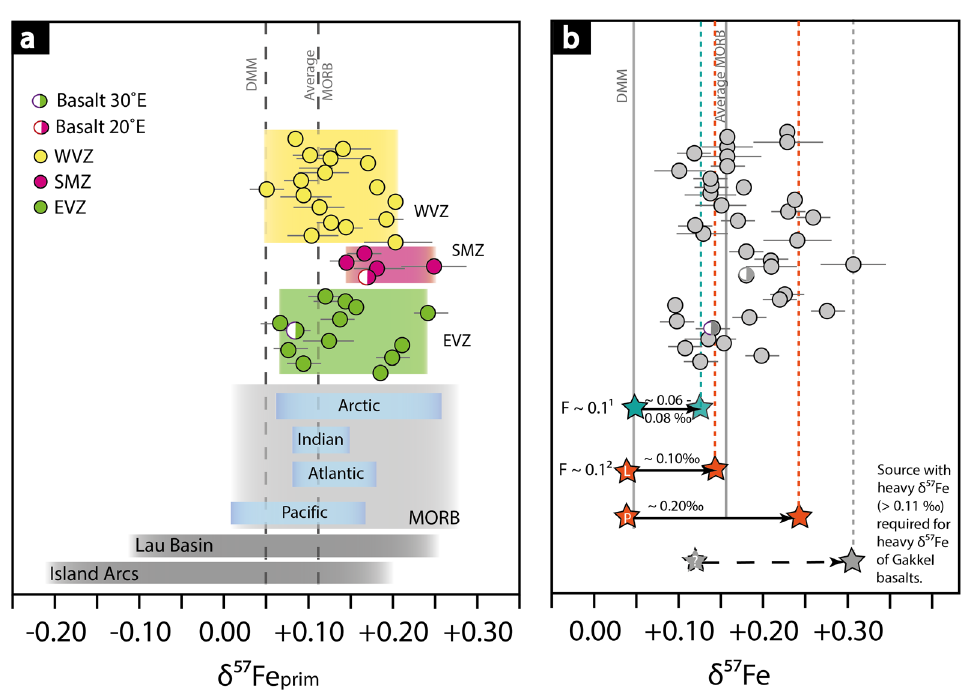
Figure 5. Primitive Fe isotope composition and overview of partial melting models. (a) Comparison of δ 57 Fe prim from different locations and tectonic settings. The different colours highlight different ridge segments, locations and tectonic settings. The δ 57 Fe prim composition of MORBs was calculated from Teng et al. 25 . The depleted MORB mantle-value is given as reference 59 . Lau Basin and island arc data are compiled from Nebel et al. 40 and Foden et al. 42 . Arctic ridge data shown in the grey box, represents the overall variability in Gakkel basalts from this study. (b) δ 57 Fe of the Gakkel basalts with an overlay of melt and initial δ 57 Fe compositions derived from partial melting models 42,62 . The stars connected by an arrow show the initial δ 57 Fe composition of the source and the corresponding melt at 10% partial melting. 1—In Foden et al. 42 the depleted MORB mantle with an initial δ 57 Fe of + 0.05 modelled, which produce melts between 0.11 and 0.13. 2—Williams and Bizimis 62 showed that lherzolite (L) and pyroxenite (P) with an initial δ 57 Fe of 0.04 ‰ can produce corresponding melts with δ 57 Fe increasing in 0.1–0.25 ‰, respectively. To allow for the heavy δ 57 Fe of the Gakkel Ridge (> 0.20 ‰) the source needs to be isotopically heavier than the depleted MORB mantle. The grey star at δ 57 Fe = 0.11 ‰ marks a hypothetical source composition for the heaviest Gakkel basalts. The heaviest δ 57 Fe composition of abyssal peridotites, which are considered as the melting residue of MORBs, from the Gakkel Ridge have a value of ~ 0.10 ‰ (LOI < 1.0 wt.%) 59 . To achieve a source with such values, it is likely that the source requires a higher modal composition in pyroxene or is of metasomatic